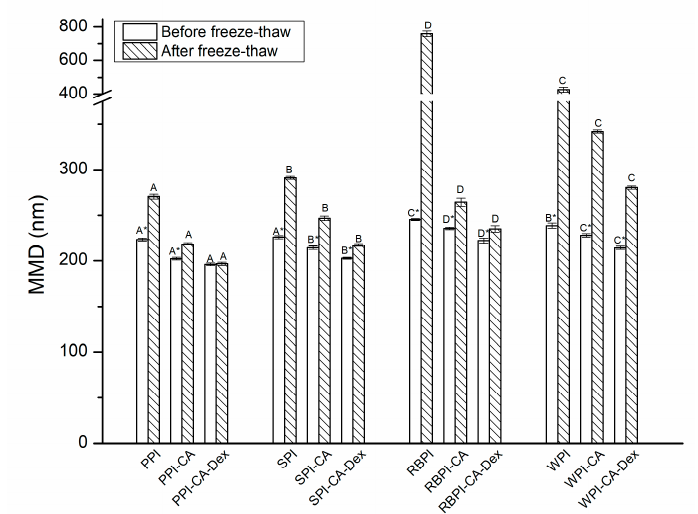
Figure 9. The MDD of nanoemulsions stabilized by NP, PC, and PCD samples after freeze-thaw treatment. A–D represented that there were statistically differences ( p < 0.05) in MDD among nanoemulsions stabilized by four NPs, four PCs or four PCDS. * represented that there were statistically differences ( p < 0.05) in MDD between same samples after freeze-thaw treatment.